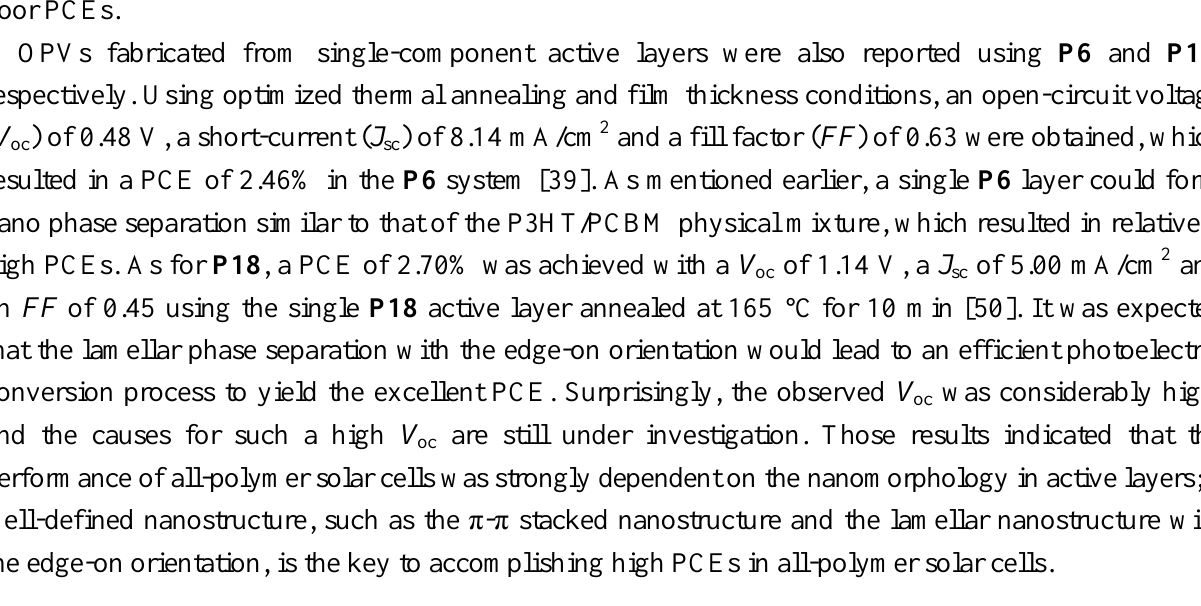
Table 1. All-polymer solar cells using donor-acceptor block